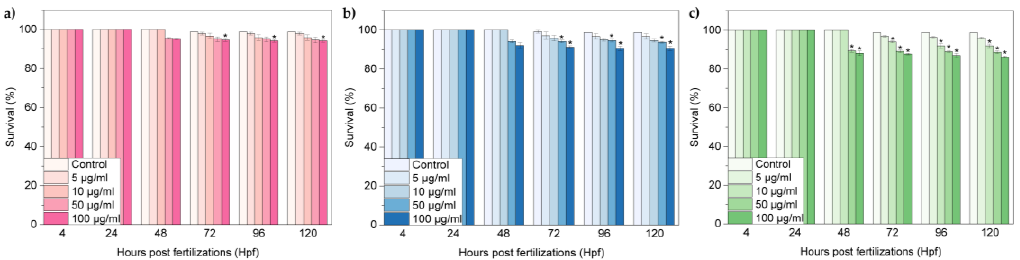
Figure 4. Survival rate of zebrafish treated with ( a ) oxi-CNOs, ( b ) oxi-CNHs and ( c ) GO. Values are expressed as means ± S.D.